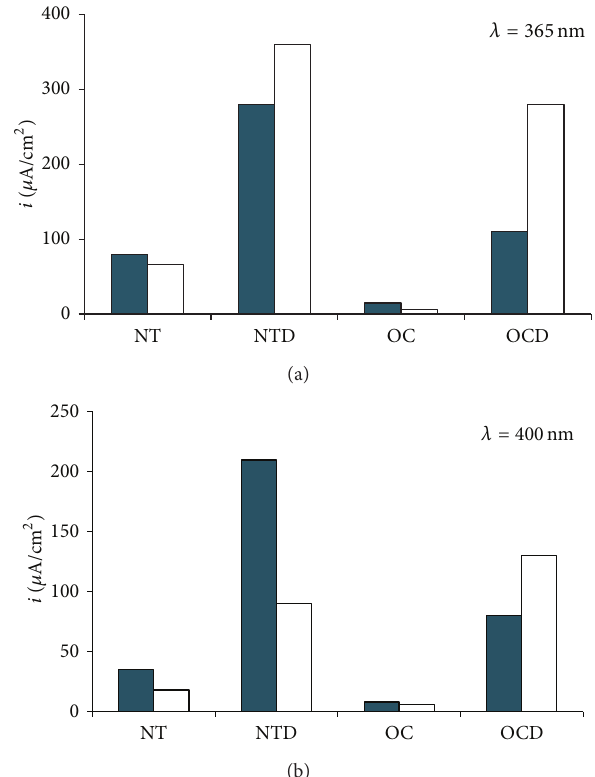
Figure9:Valuesofphotocurrentobtainedat365 nm(a)and400nm (b) in the BC (full bars) and in TGC (empty